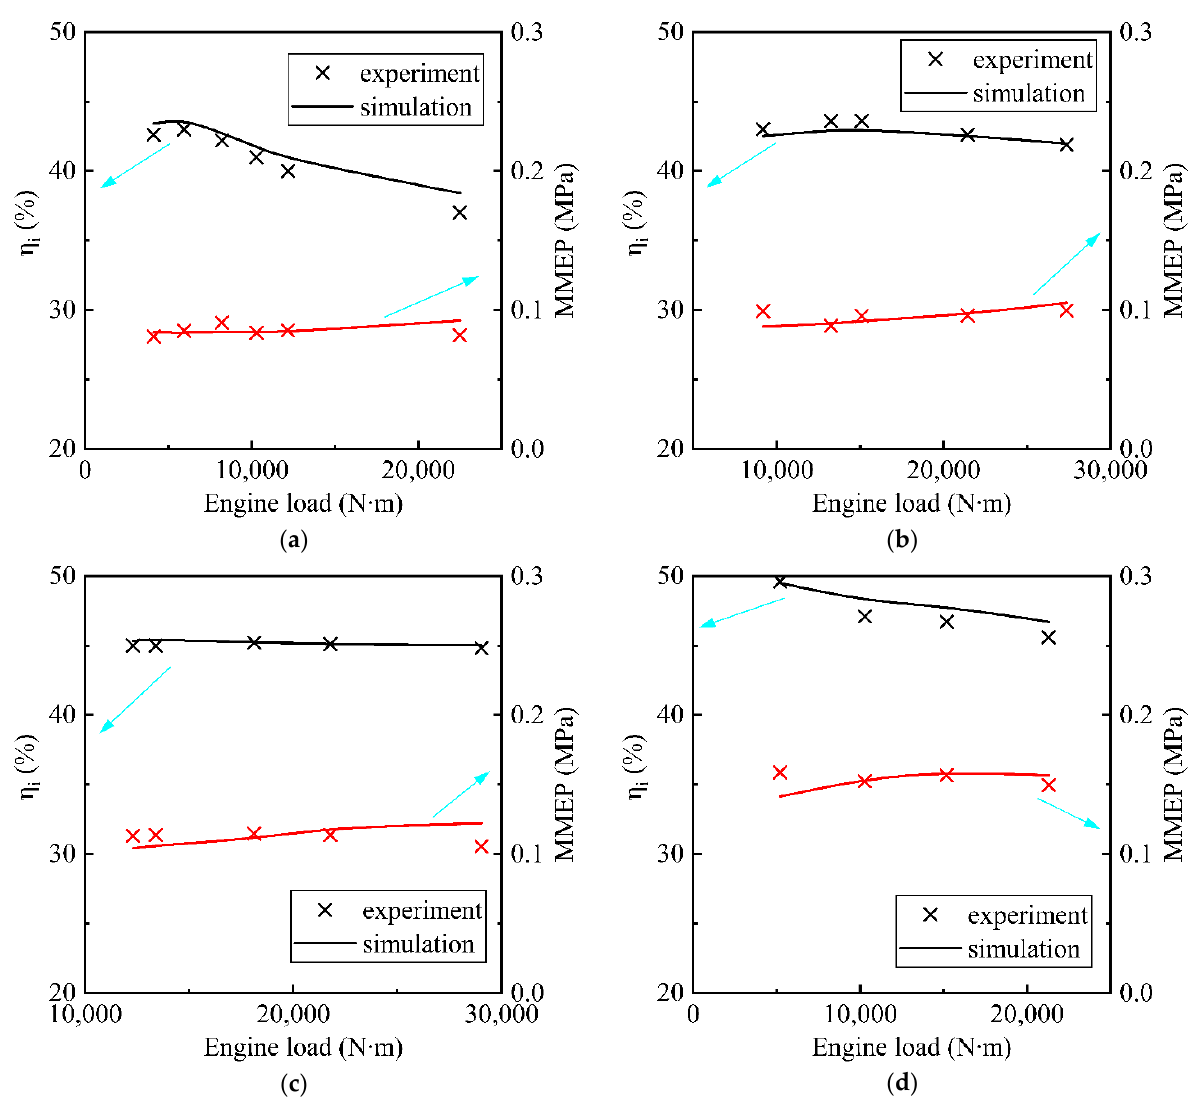
Figure 4. Comparisons of simulations and experiments at engine speed: ( a ) 450 rpm; ( b ) 556 rpm; ( c ) 742 rpm; ( d ) 1000 rpm.